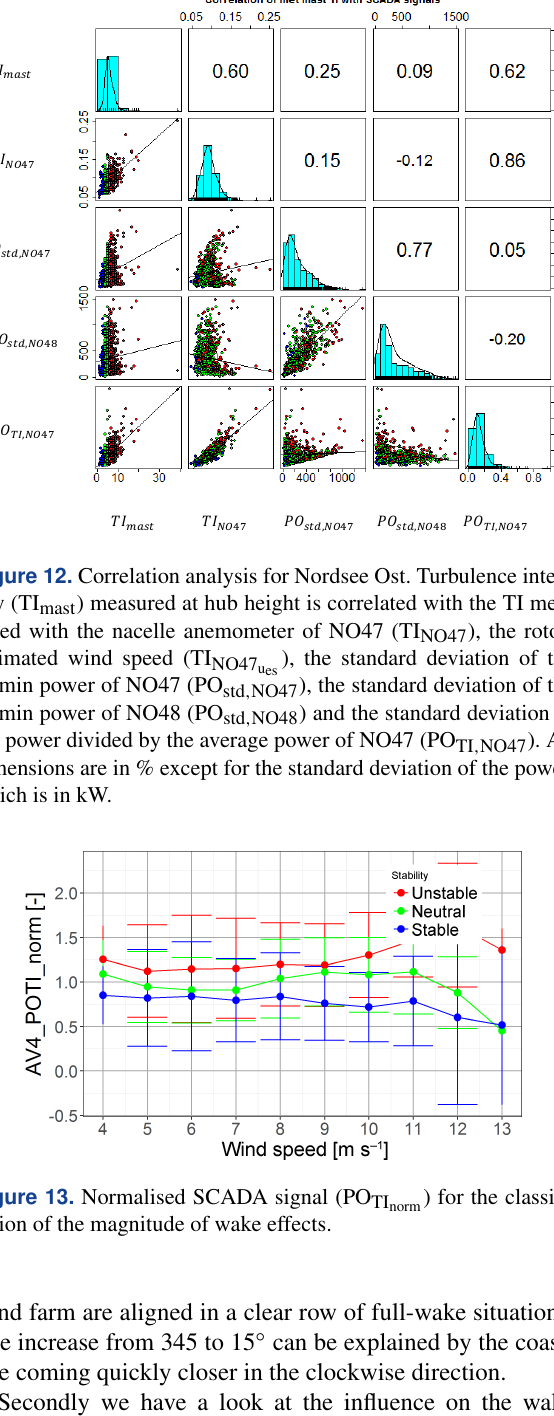
) for the classifi- norm